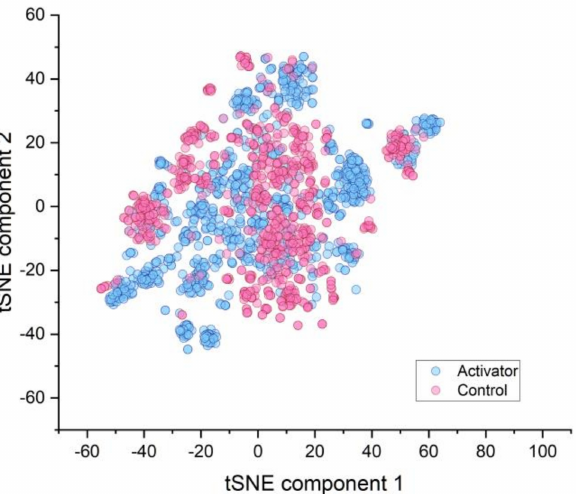
Figure 1. t -distributed stochastic neighbor embedding (tSNE) analysis: AMPK activators and con- trols.